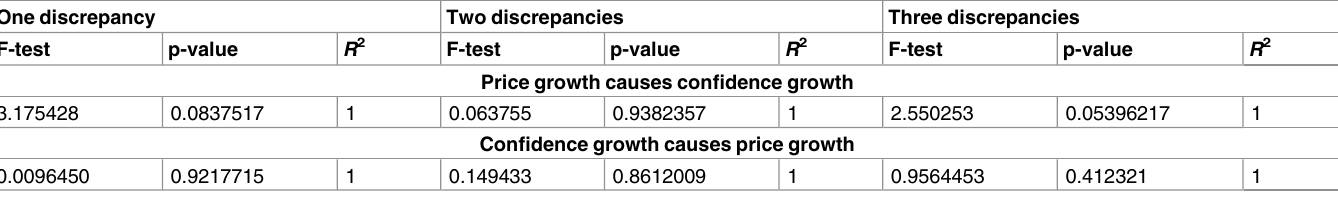
Table 6. Results of the Granger test for the causality relationship analysis between the growth rate of confidence and the growth rate of